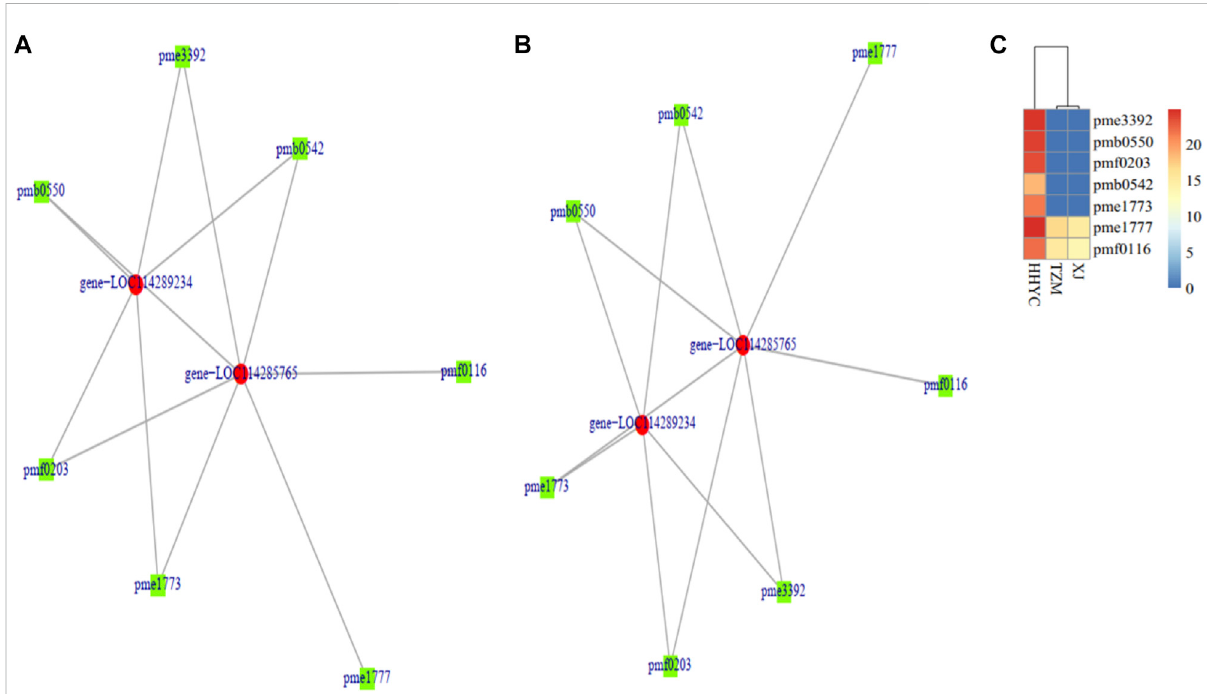
FIGURE 7 Pearson correlation network diagramofdifferentially expressed genes(DEGs)and differentiallyaccumulated metabolites(DAMs)abundancein pairwise comparison of C. reticulata (HHYC), C. reticulata ‘ Xuejiao ’ (XJ) and C. reticulata ‘ Tongzimian ’ (TZM). (A) . HHYC_vs_XJ. (B) . HHYC_vs_TZM. (C) .Heatmapclusteringofsevenmetabolitesbasedonlog2transformedofionintensities.Themetabolitespme3392(pelargonidin-3-O-glucoside), pmb0550 (cyanidin-3-O-glucoside (kuromanin)), pmf0203 (peonidin-3-O-glucoside), pmb0542 (cyanidin-3-O-(6 ″ -O-malonyl) glucoside), pme1773 (cyanidin-3-O-rutinoside (keracyanin)), pme1777 (cyanidin-3,5-O-diglucoside (cyanin)) and pmf0116 (delphinidin-3,5-di-O-glucoside). The DEGs in the network ( gene-LOC114285765 and gene-LOC114289234 encode for anthocyanidin 3-O-glucosyltransferase [EC:2.4.1.115] designated BZI in Anthocyanin biosynthetic pathway in Supplementary Figure S3). Color diagram at the right side shows the intensity of the metabolite